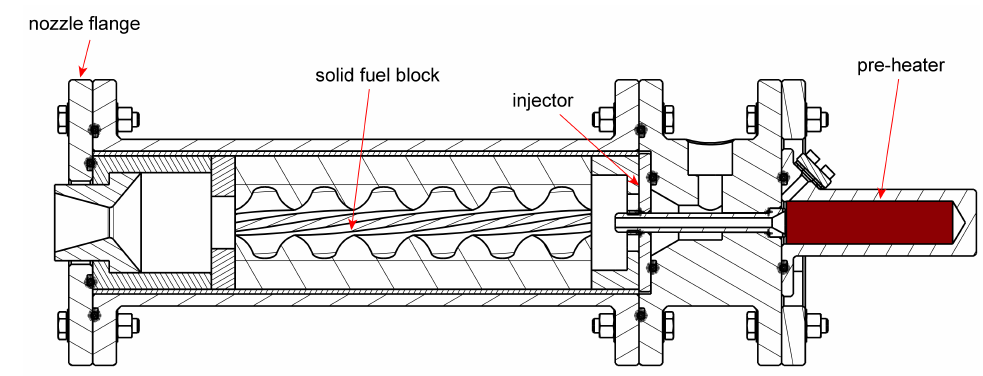
Figure 9. Sectional view of the hybrid rocket